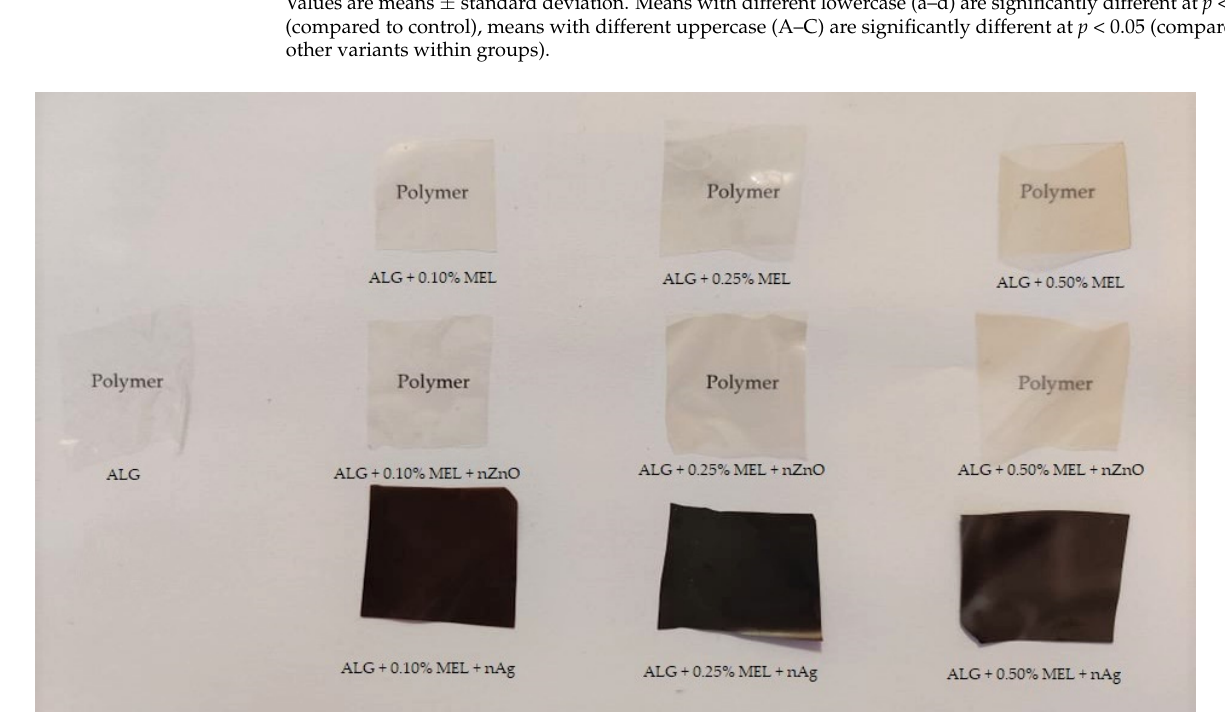
Figure 9. The visual appearance of neat and modified alginate